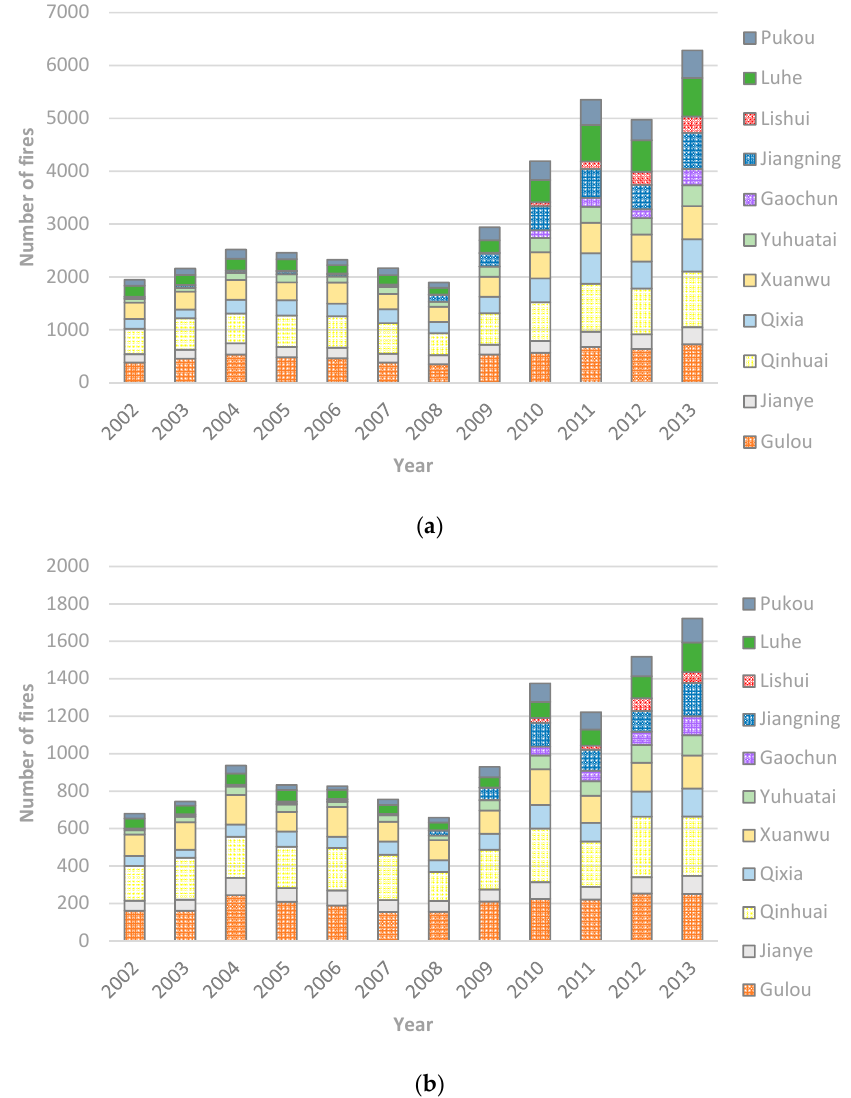
Figure 4. Temporal variations of urban fires (2002–2013): ( a ) total fire and ( b ) dwelling fire.